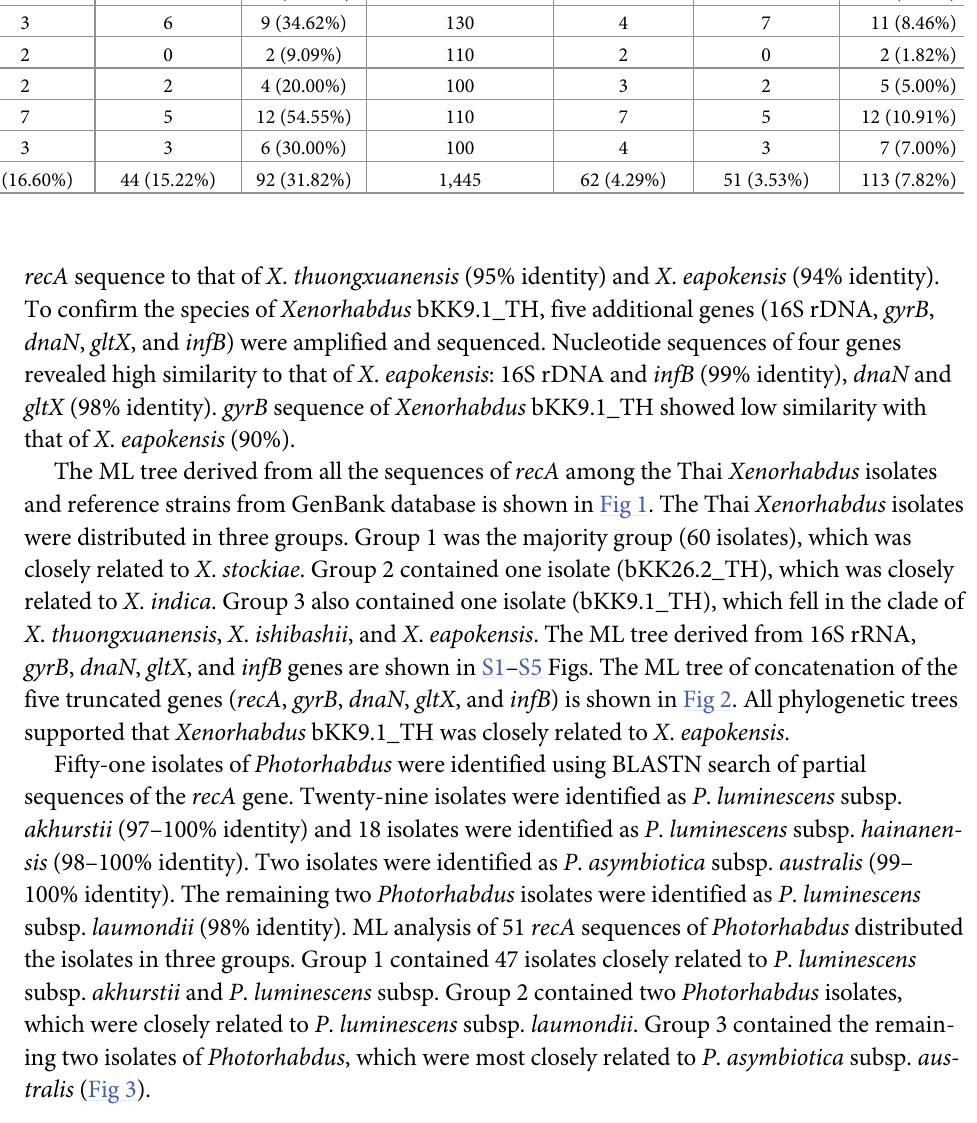
Table 2. pH, temperature, and moisture content of the soil samples (n = 1,445) in the presence and absence of EPNs. Soil parameter Soil with EPNs Soil without EPNs P -value (Mann-Whitney test) (n = 113) (n = 1,332) Range Mean Range Mean